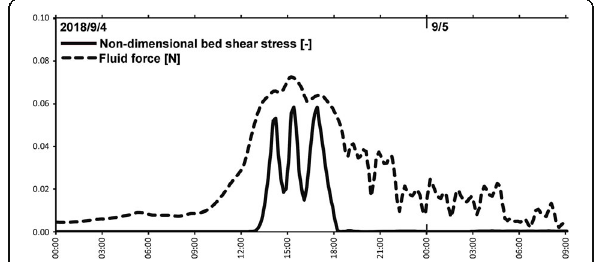
Fig. 16 Simulated time series of the nondimensional bed shear stress (solid line) and fluid force acting on the submerged macrophytes (broken line) averaged over the area of the southern basin during the period from 0:00 on 4 September to 9:00 JST